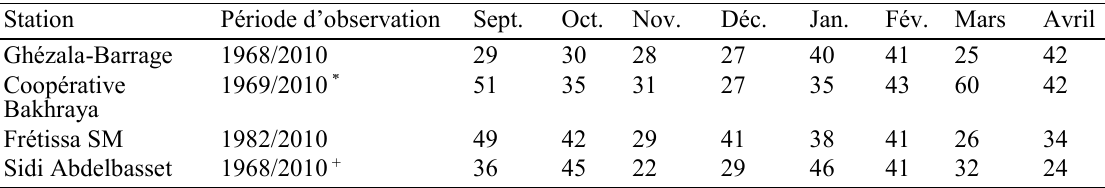
Tableau 1 Durée de la période sèche mensuelle maximum (en